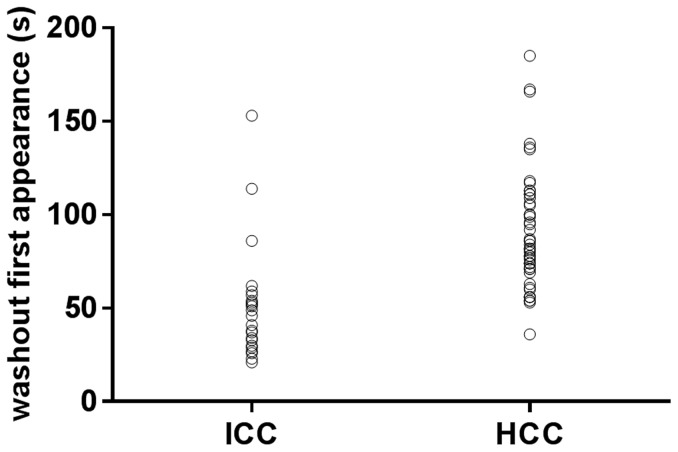
Frequency distribution of washout onset in portal phase (seconds).Washout onset is earlier in patients with intrahepatic cholangiocellular carcinoma (ICC) than in those with hepatocellular carcinoma (HCC).